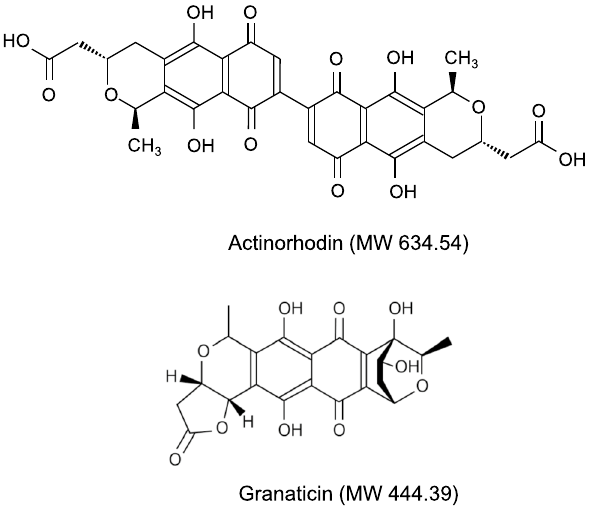
Figure 1. Chemical structure of actinorhodin and